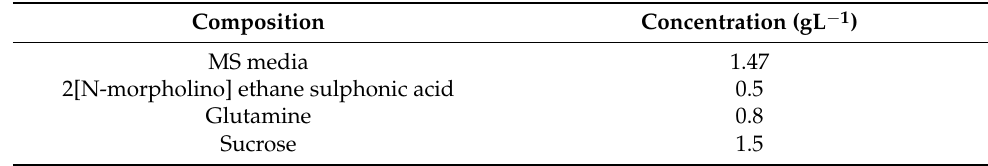
Table 1. Composition of ear culture